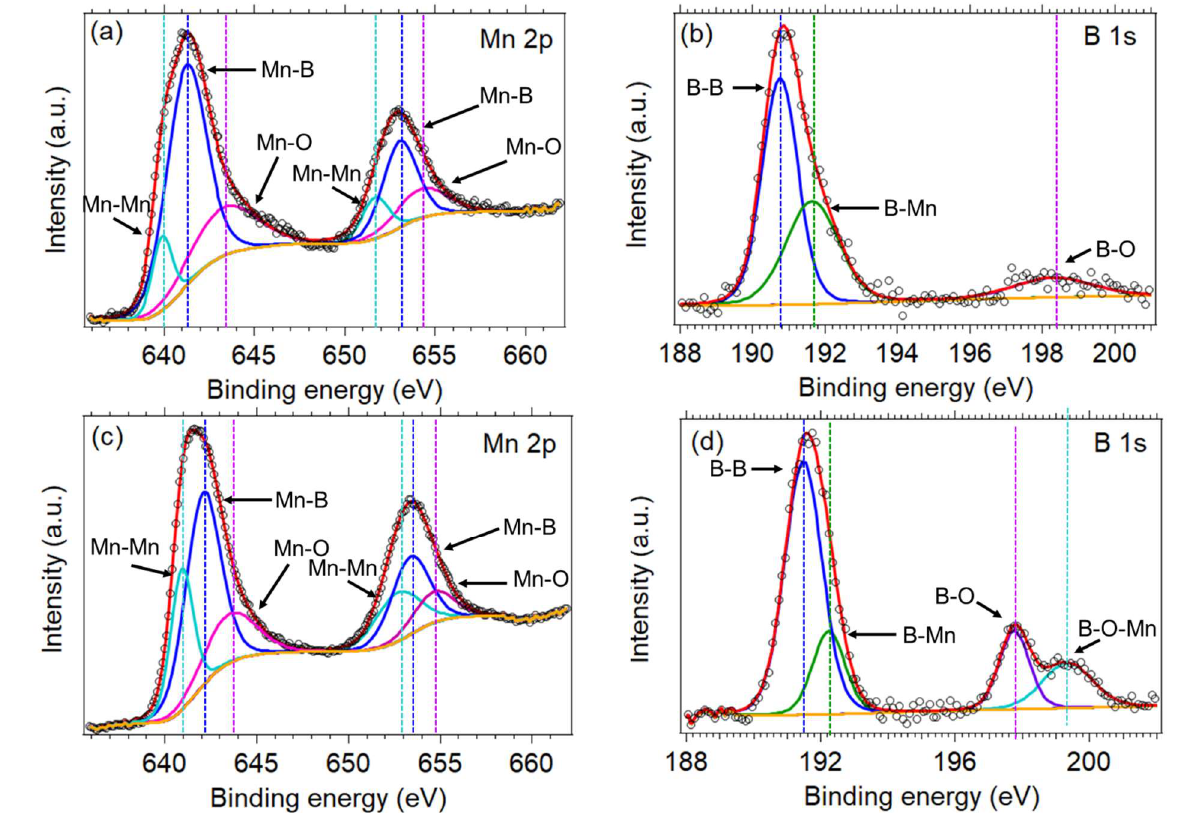
Figure 5. Mn 2p XPS and B 1s spectra of the ( a , b ) MnB−I and ( c , d ) MnB−II. The black circle markers represent the experimental intensity, the red line represents the fitted data, and the yellow solid line represents the background.